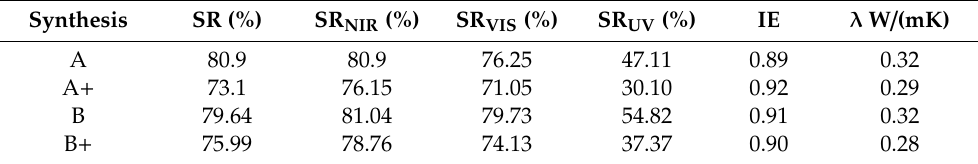
Table 4. Reflectance, infrared emittance (IE), and thermal conductivity ( λ ) of the designed mortars* Synthesis